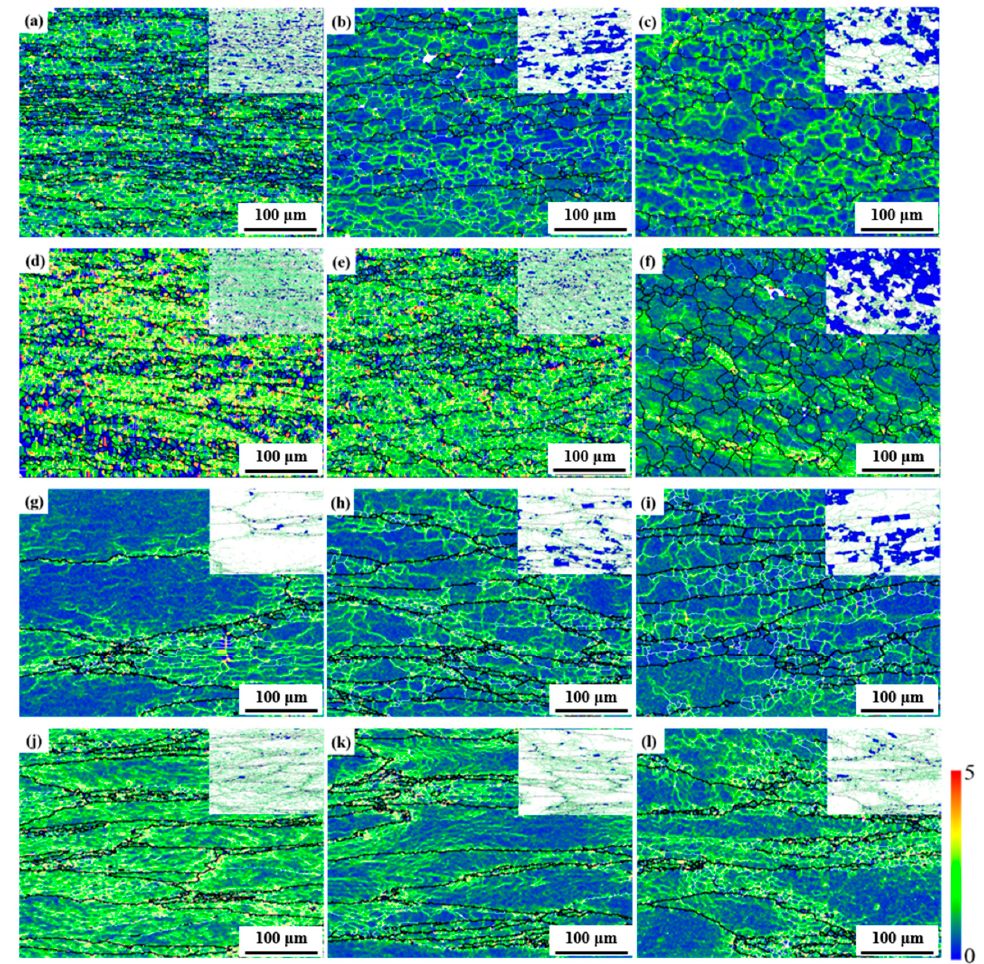
Figure 14. KAM and recrystallization of AC and HG AA2195 Al-Li alloy under different hot deformation conditions: ( a ) AC-360 °C /0.01s − 1 , ( b ) AC-420 °C /0.01s − 1 , ( c ) AC-480 °C /0.01s − 1 ; ( d ) AC-360 °C /10s − 1 , ( e ) AC-420 °C /10s − 1 , ( f ) AC-480 °C /10s − 1 ; ( g ) HG-360 °C /0.01s − 1 , ( h ) HG-420 °C /0.01s − 1 , ( i ) HG-480 °C /0.01s − 1 ; ( j ) HG-360 °C /10s − 1 , ( k ) HG-420 °C /10s − 1 , ( l ) HG-480 °C /10s − 1 .